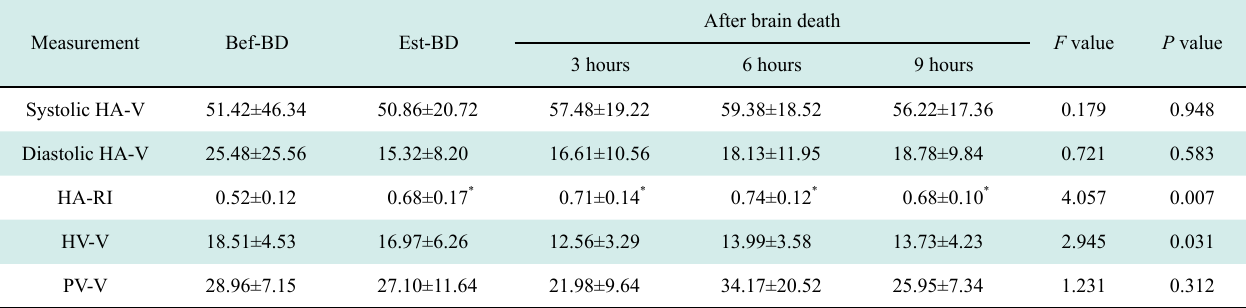
Table 4 Doppler parameters changes at Bef-BD, Est-BD, and 3, 6, and 9 hours after brain death. Measurement